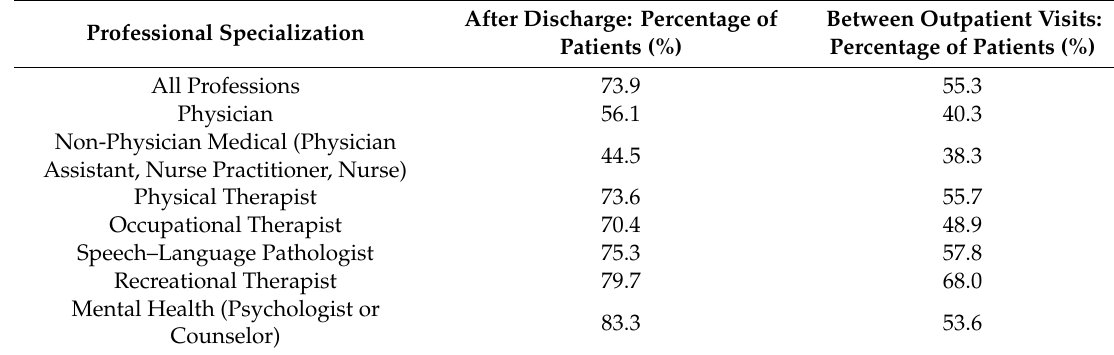
Table 4. Percentage of patients who require additional therapeutic interventions (excluding medications)